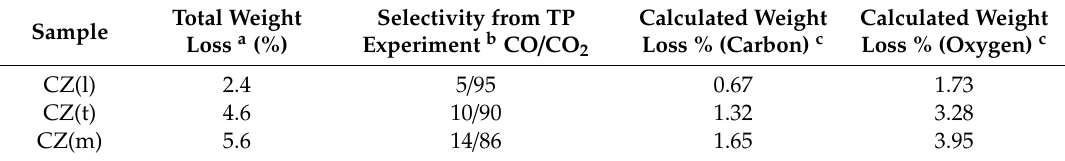
Table 2. Summary of results for soot oxidation under inert conditions.